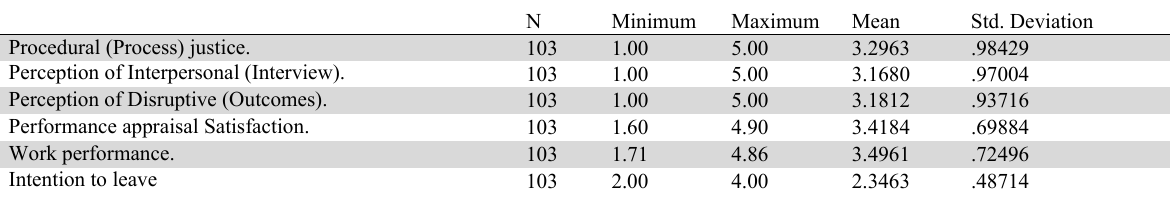
The summary of some basic